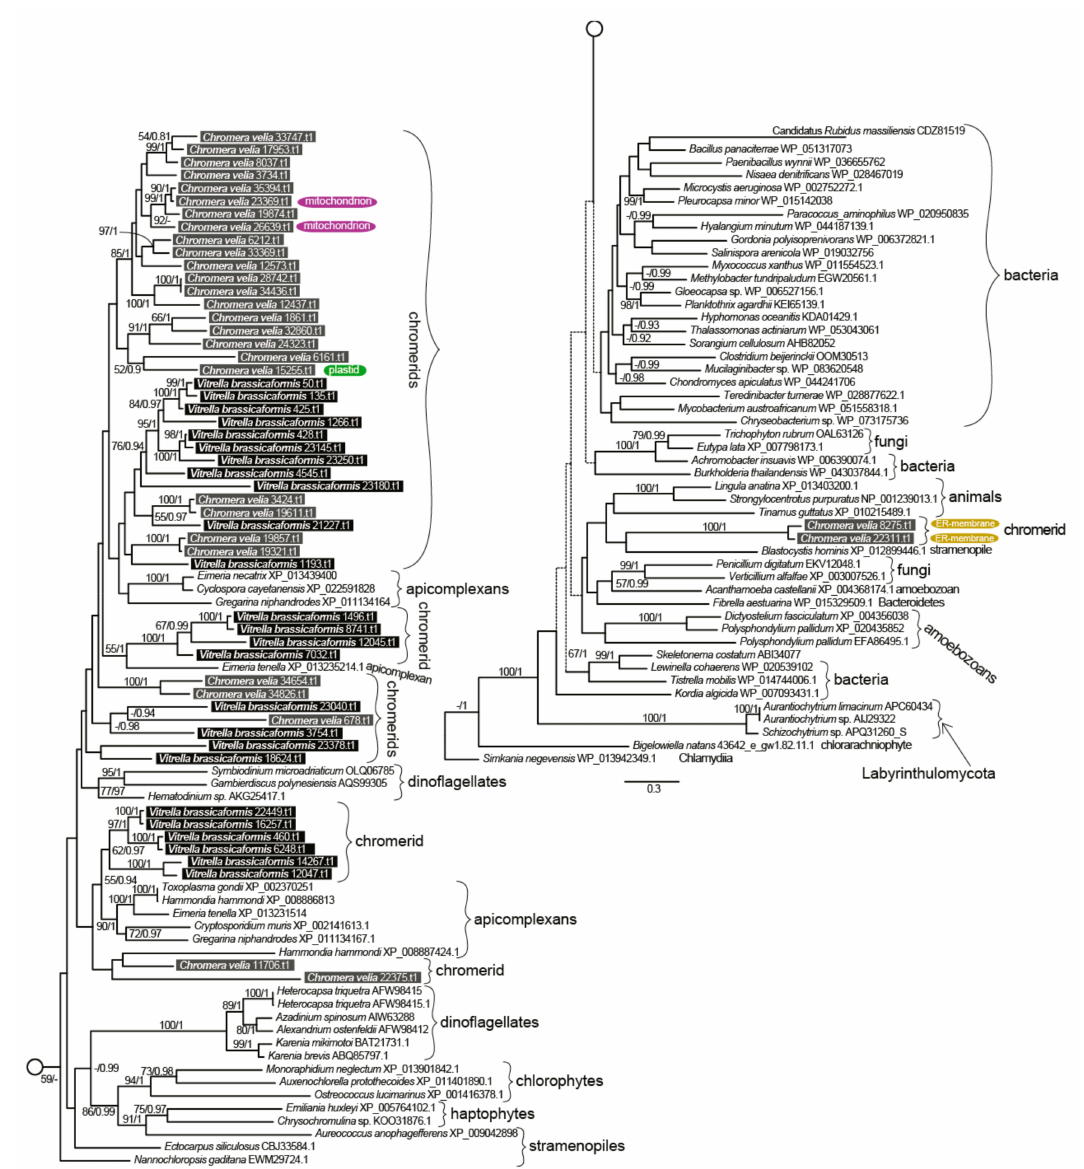
Figure 4. The detailed phylogeny of ketoacyl synthase domains of type I fatty acid synthases and polyketide synthases. Bootstrap for 1000 repetitions and Bayesian pp values (BS1000 / 1M, CAT /